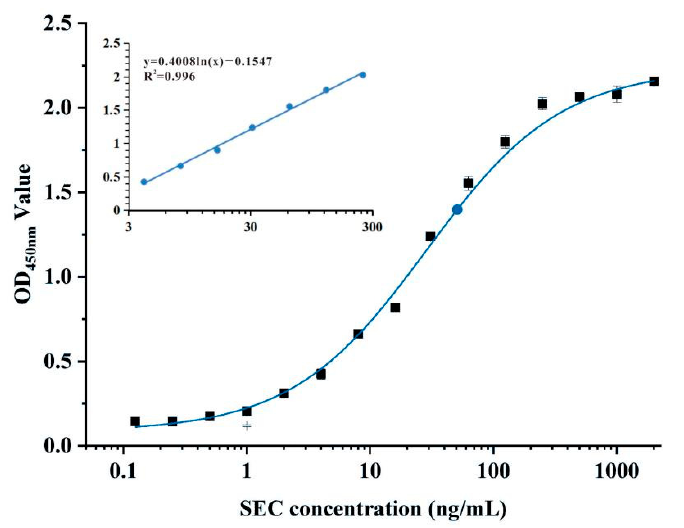
Figure 4. The calibration curve of the sandwich Nbs-ELISA SEC detection. Each value represents the average of three replications, as well as the standard deviations.